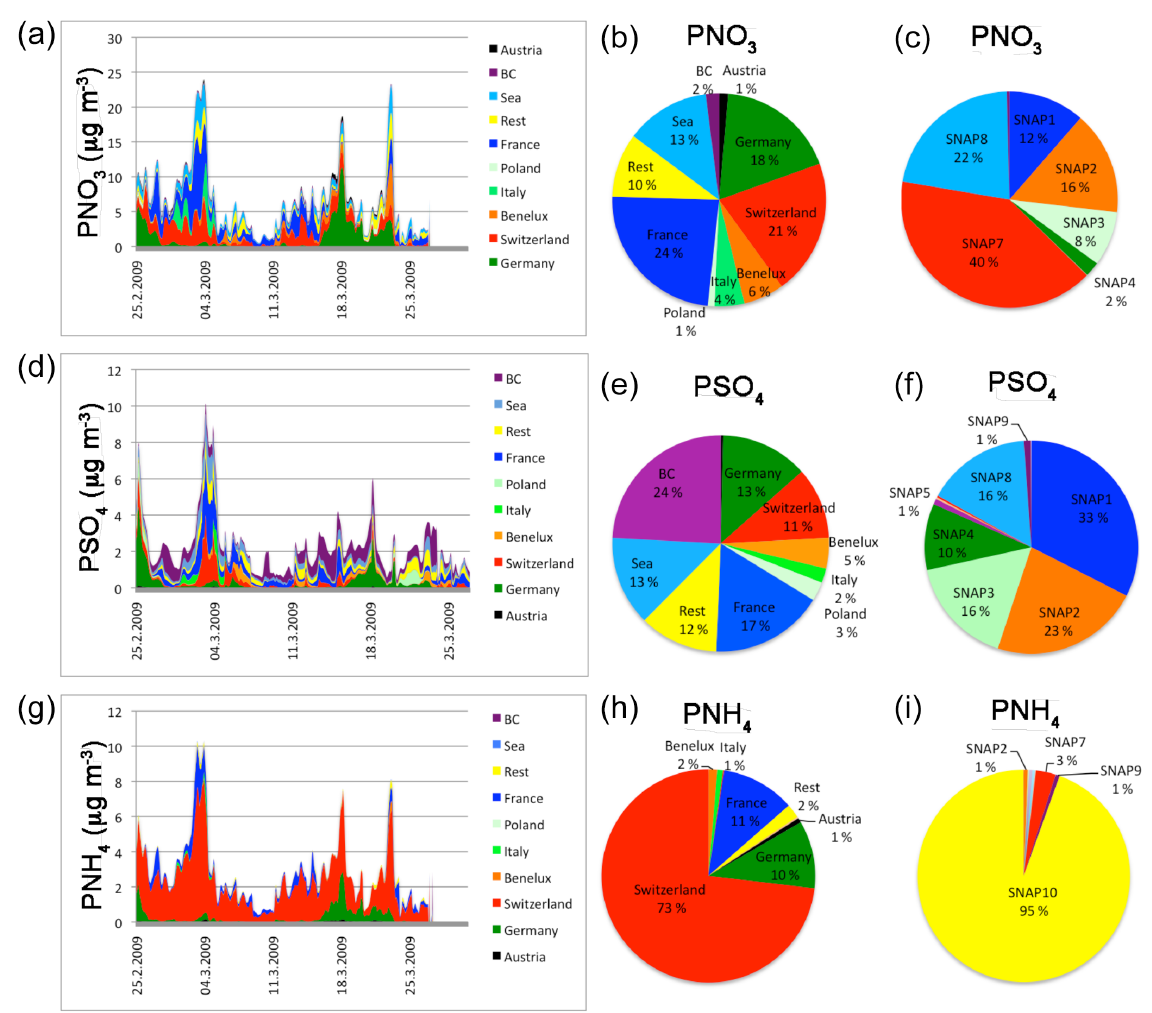
Figure 9. Contributions from various source regions (time series on a, d, g , pie-charts in b, e, h ) and categories (pie-charts on c, f, i ) to the concentrations of PNO 3 (a–c) , PSO 4 (d–f) and PNH 4 (g–i) in the Swiss Plateau during February–March 2009. BC: boundary